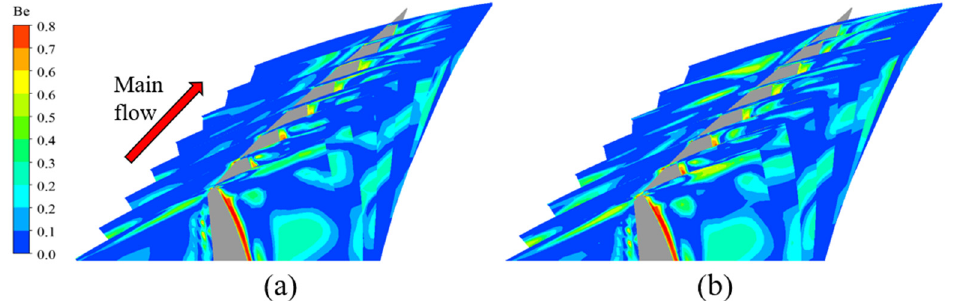
Figure 11. Contours of Be number in the tip region. ( a ) SES; ( b ) CCT.